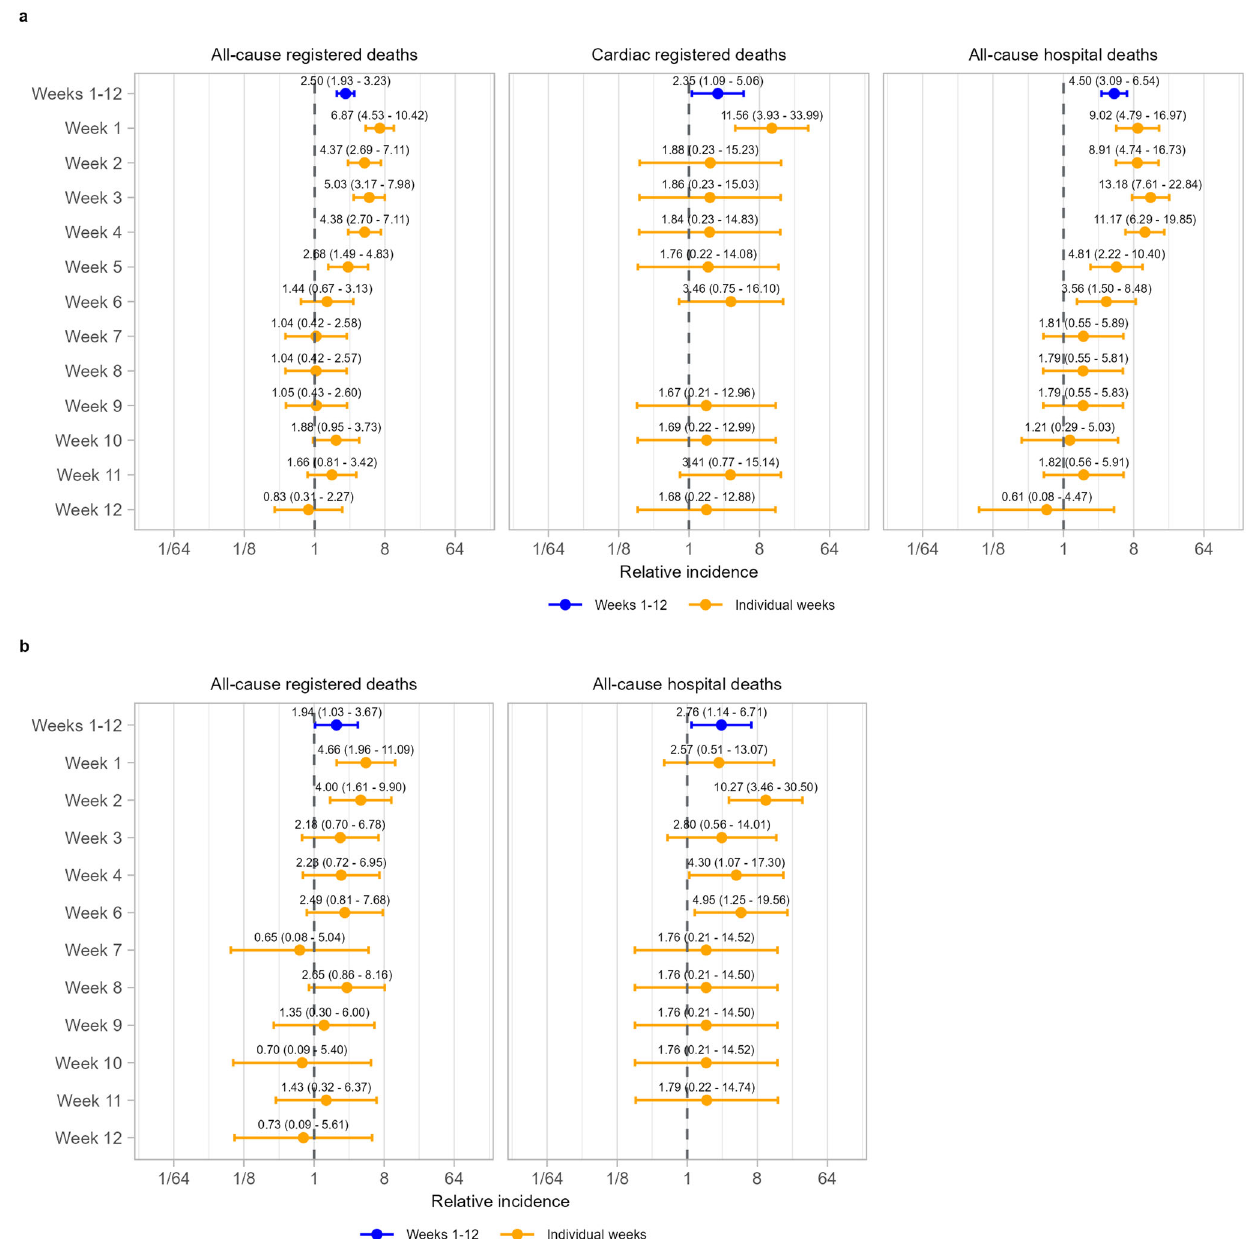
Fig. 3 | Relative incidence of cardiac death and all-cause death in each of the 12 weeksintheriskperiodafter SARS-CoV-2 infectionandintheriskperiodas a whole, compared to the baseline period. Data are presented as incidence rate ratiowith95%con fi denceintervals.Modelsareadjustedforcalendartime. n =3219